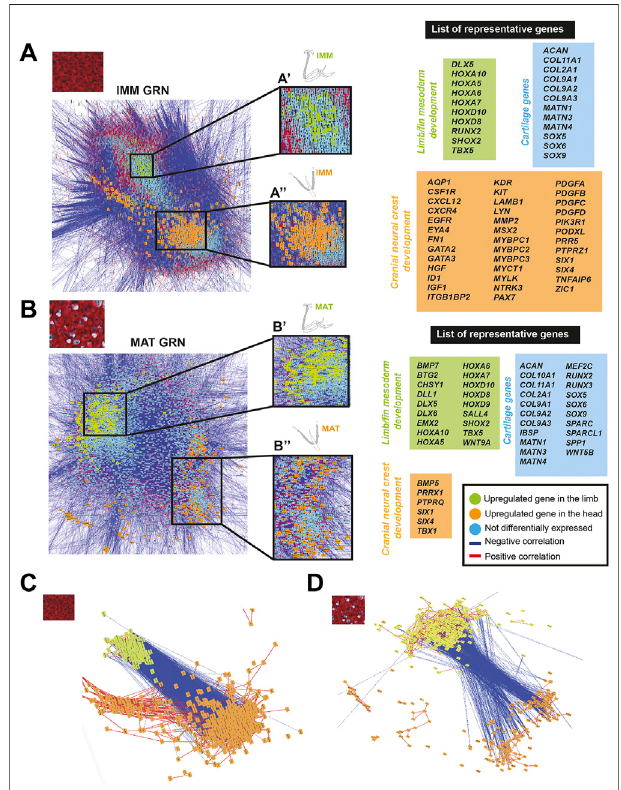
FIGURE5| GCNofeitherIMMorMATchondrocytedatawasorganized into groups of enriched limb or head genes that were negatively correlated with each other. (A,B) A GRN underlying IMM (A) or MAT (B) differentiation was estimated from a GCN from limb and head chondrocytes (IMM and MAT data separately normalized). In both IMM and MAT GRNs, one portion contained genes upregulated in the limb (green nodes), while another portion containedgenesupregulatedinthehead(orangenodes).Typicalchondrocyte differentiation genes included in the network (light blue nodes) were not differentially expressed between limb and head. Representative lists of genes in each of these three categories are shown to the side of the GRNs. (C,D) Isolated portions of limb- and head-enriched genes in the IMM (C) and MAT (D) GRNs. Most upregulated genes in limb or head were connected by positive interactions (red lines), whereas limb and head genes were mostly connected by negative interactions (blue lines).